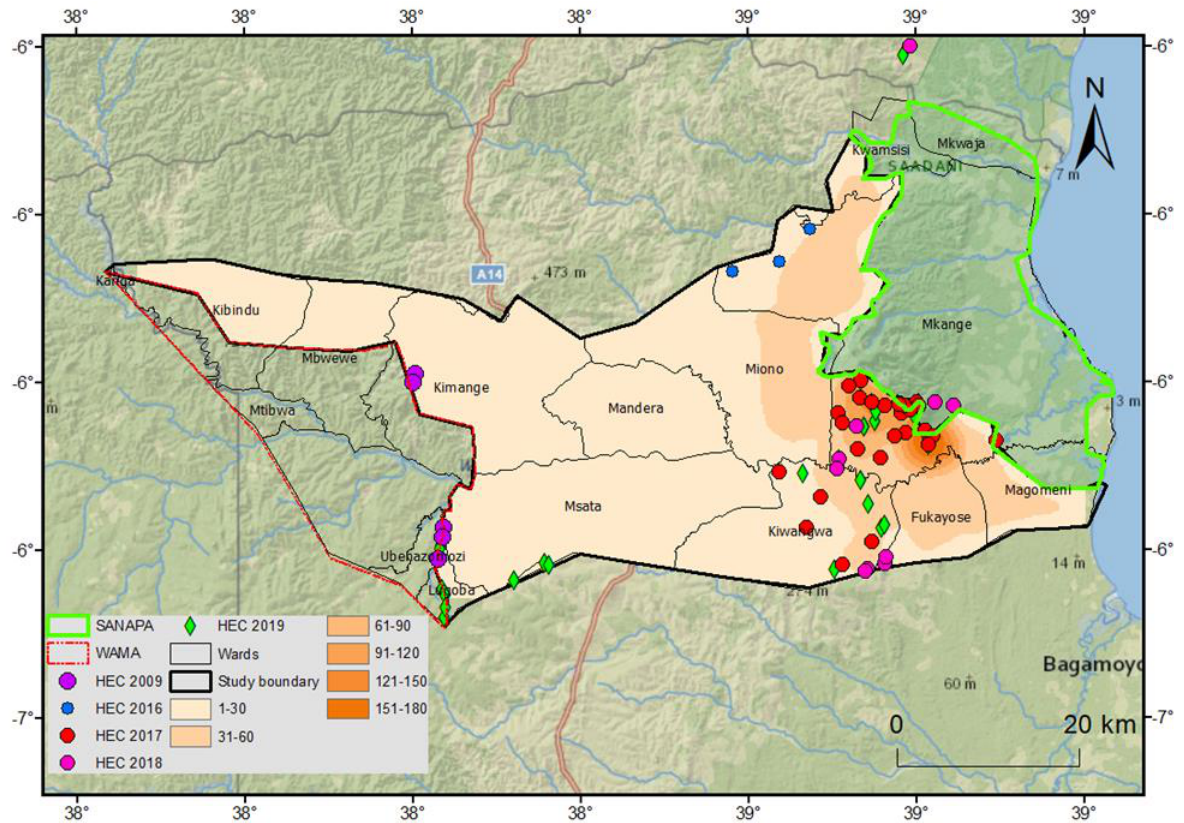
Figure 4. Heat map for human-elephant conflict (HEC) hotspots reported per year by the District Game officers of Handeni, Chalinze and Bagamoyo in Wami Mbiki-Saadani Wildlife corridor, Tanzania, in 2009, 2016, 2017, 2018, and 2019 (different symbols). The color shades indicate the intensity based on the number of reported cases. The heat map was generated by using kernel density in the Spatial analyst tool of ARC GIS in the WMS wildlife corridor. WMA = wildlife management area, SANAPA = Saadani National Park.